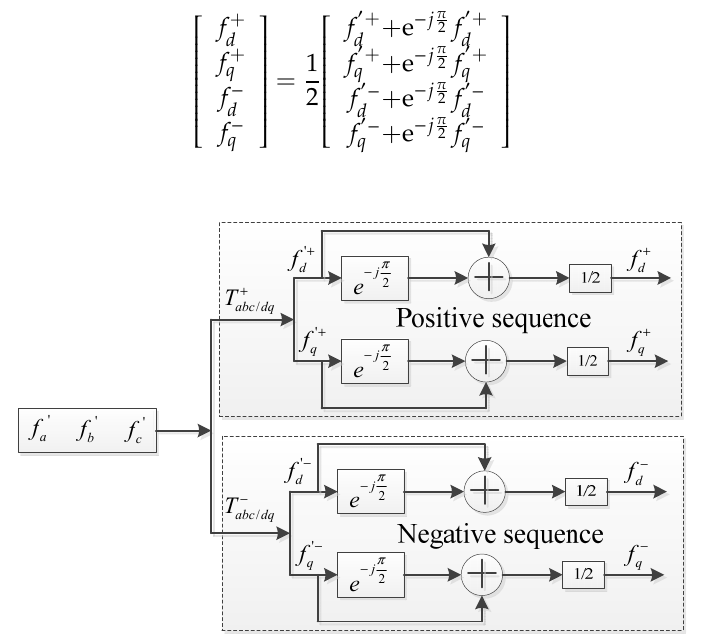
Figure 8. Positive and negative sequence separation and extraction flow chart.